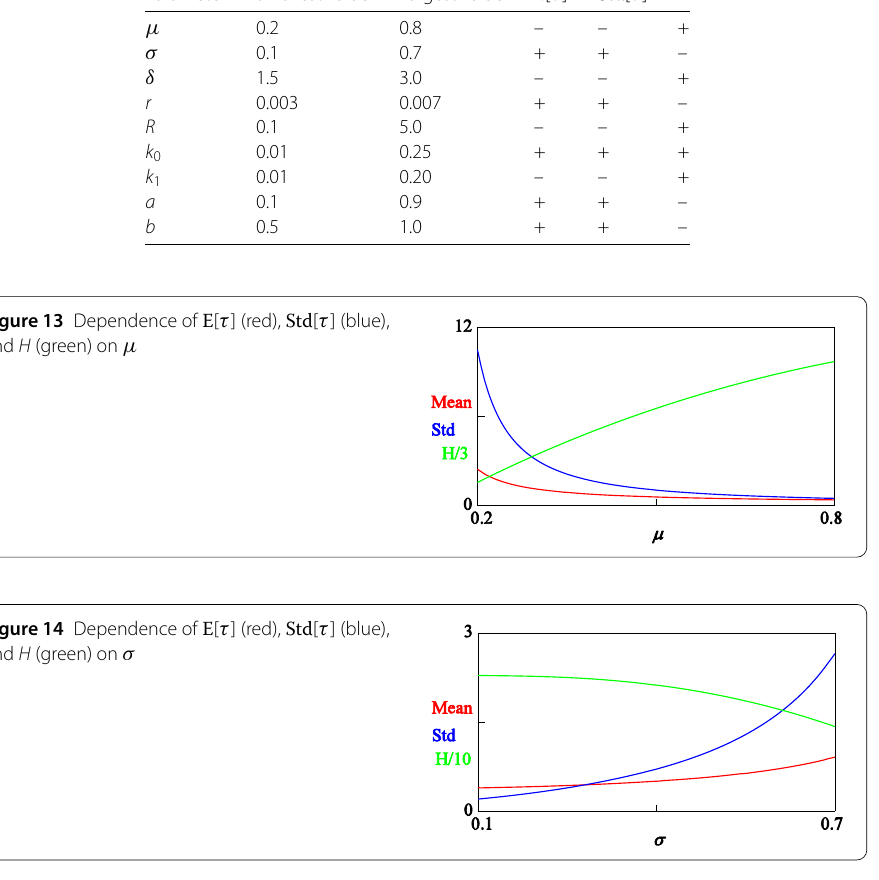
time increment 0.00001) are E[ τ ] = 0.5898, Std[ τ ] = 1.0422, and H = 19.47. The